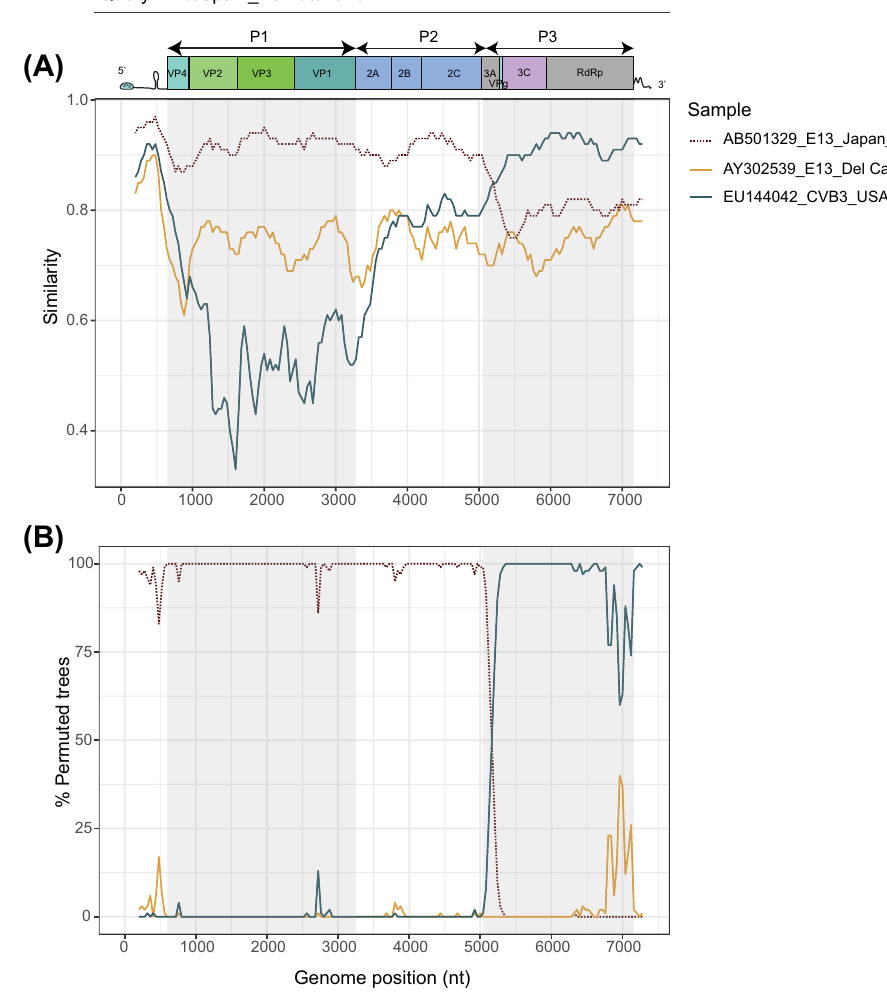
Figure 3. Plot of similarity ( A ) and bootscanning analysis ( B ) of E13/Spain_LCR53/2016 study strain with prototype and closely related strains. The enterovirus genetic organization is shown in the top panel. Analyses were conducted by using SimPlot 3.5.1 (Kimura distance model, window size 400 bp moving in 40 nucleotides